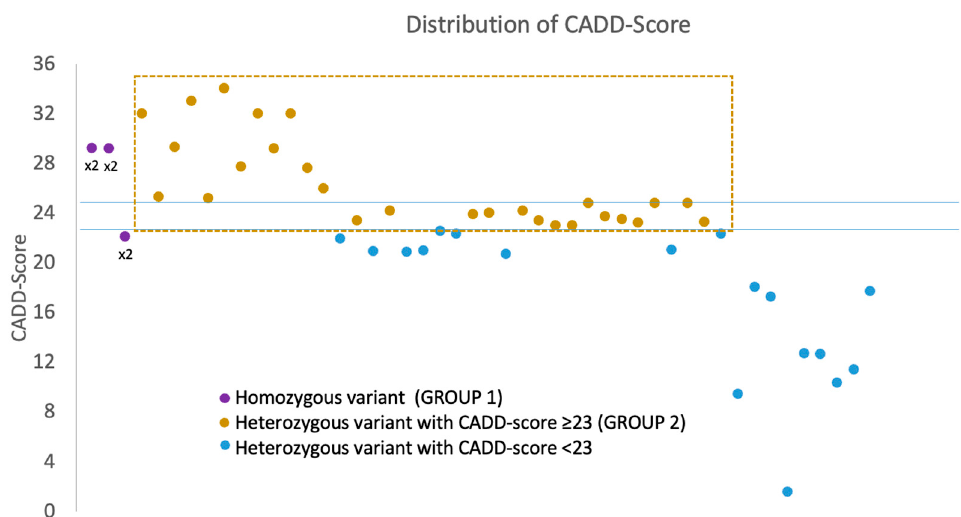
Figure 2. Graph showing the dispersion of variants ( x -axis) according to the CADD score ( y -axis). The points in purple represent the homozygous variants, the points in ocher the heterozygous variants with a CADD score greater than 23 (Group 2) and the points in blue the heterozygous variants with a CADD score less than 23 not covered by our study.